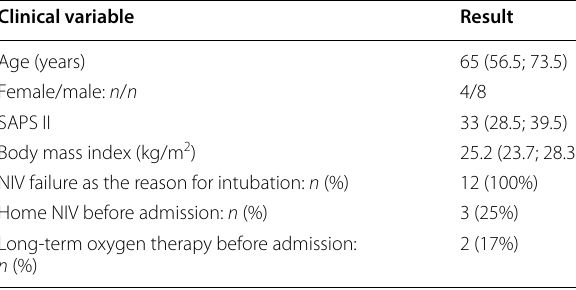
Results are expressed as median (IQR) or number of patients (%)